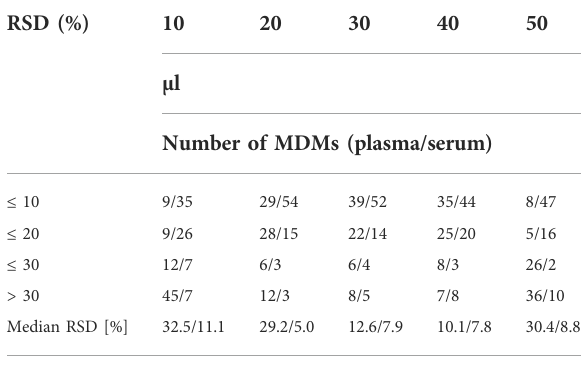
TABLE 3 Comparison of different volume of the O – methoxyamine HCl in pyridine (µl) based on the repeatability of 75 MDMs detected in both types of samples, in the table was presented number of MDMs with RSD for plasma/serum ≤ 10% – 30% and above 30%.